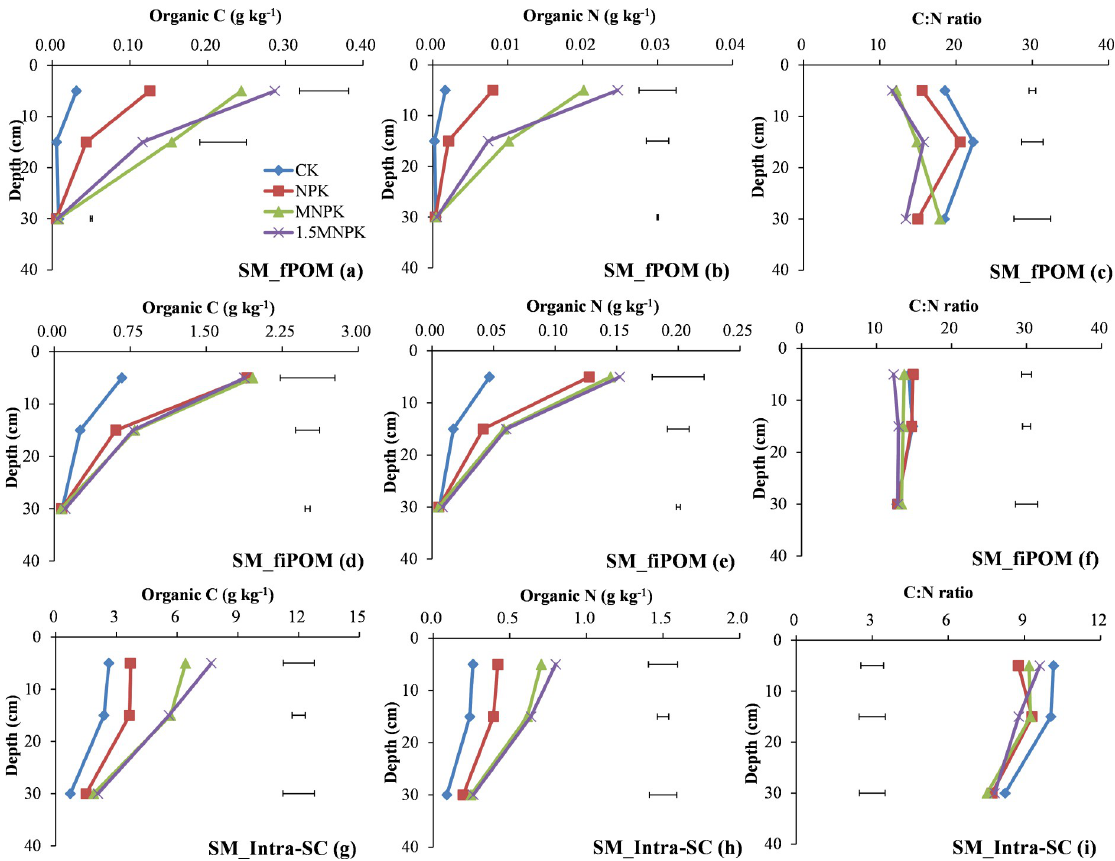
Fig 6. Change in organic C and N concentrations and their C/N ratios in microaggregates within small macroaggregate fractions of control (CK), chemical fertilizer (NPK), and combined manure and chemical fertilizer (MNPK, 1.5MNPK) treatments in the top 40 cm of the soil profile. Values at each soil depth are the mean of three replicates. The horizontal lines denote the least significant difference values at the 0.05 level (LSD0.05) among different treatments at each soil depth. Symbols of aggregate fractions: see Fig 1